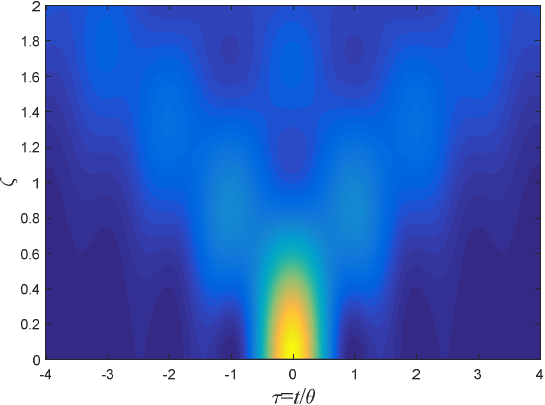
Figure 22. Same as Figure 10, but for Equation (80) and for the final distance of ζ = β 2 z / θ 2 = 0.3. The spatiotemporal presentation of the pulse’s intensity is presented in Figure 23.